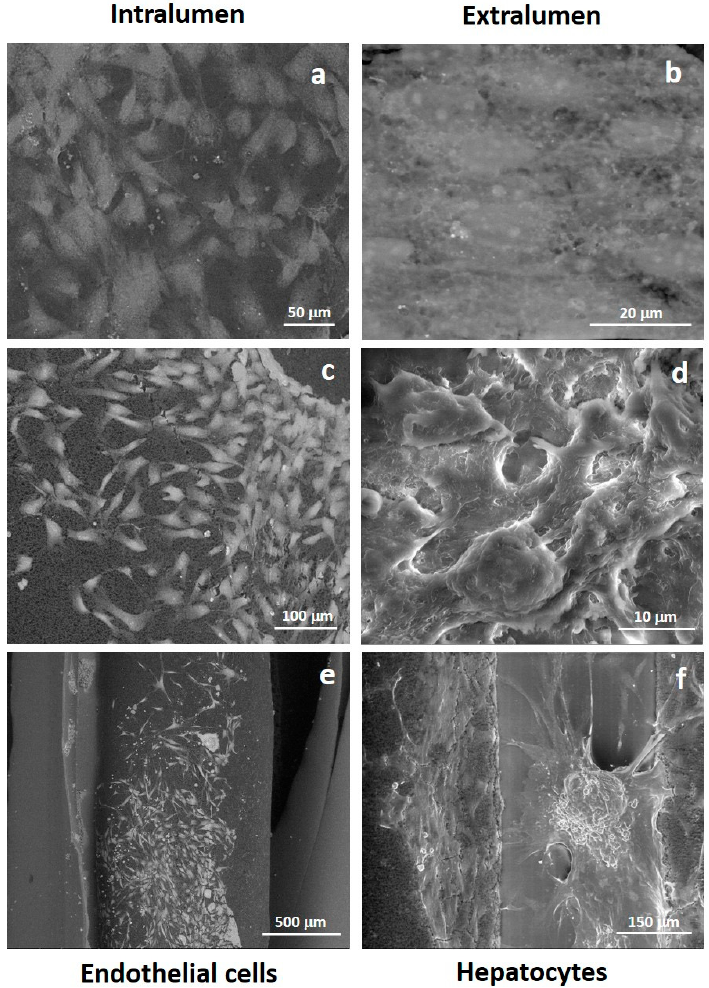
Figure 5. SEM pictures of primary human hepatocytes and human endothelial cells after 18 days of culture in PCL HF membrane bioreactor: ( a , c , e ) endothelial cells in the intraluminal compartment; ( b , d , f ) hepatocytes over and between fibers in the extraluminal compartment.